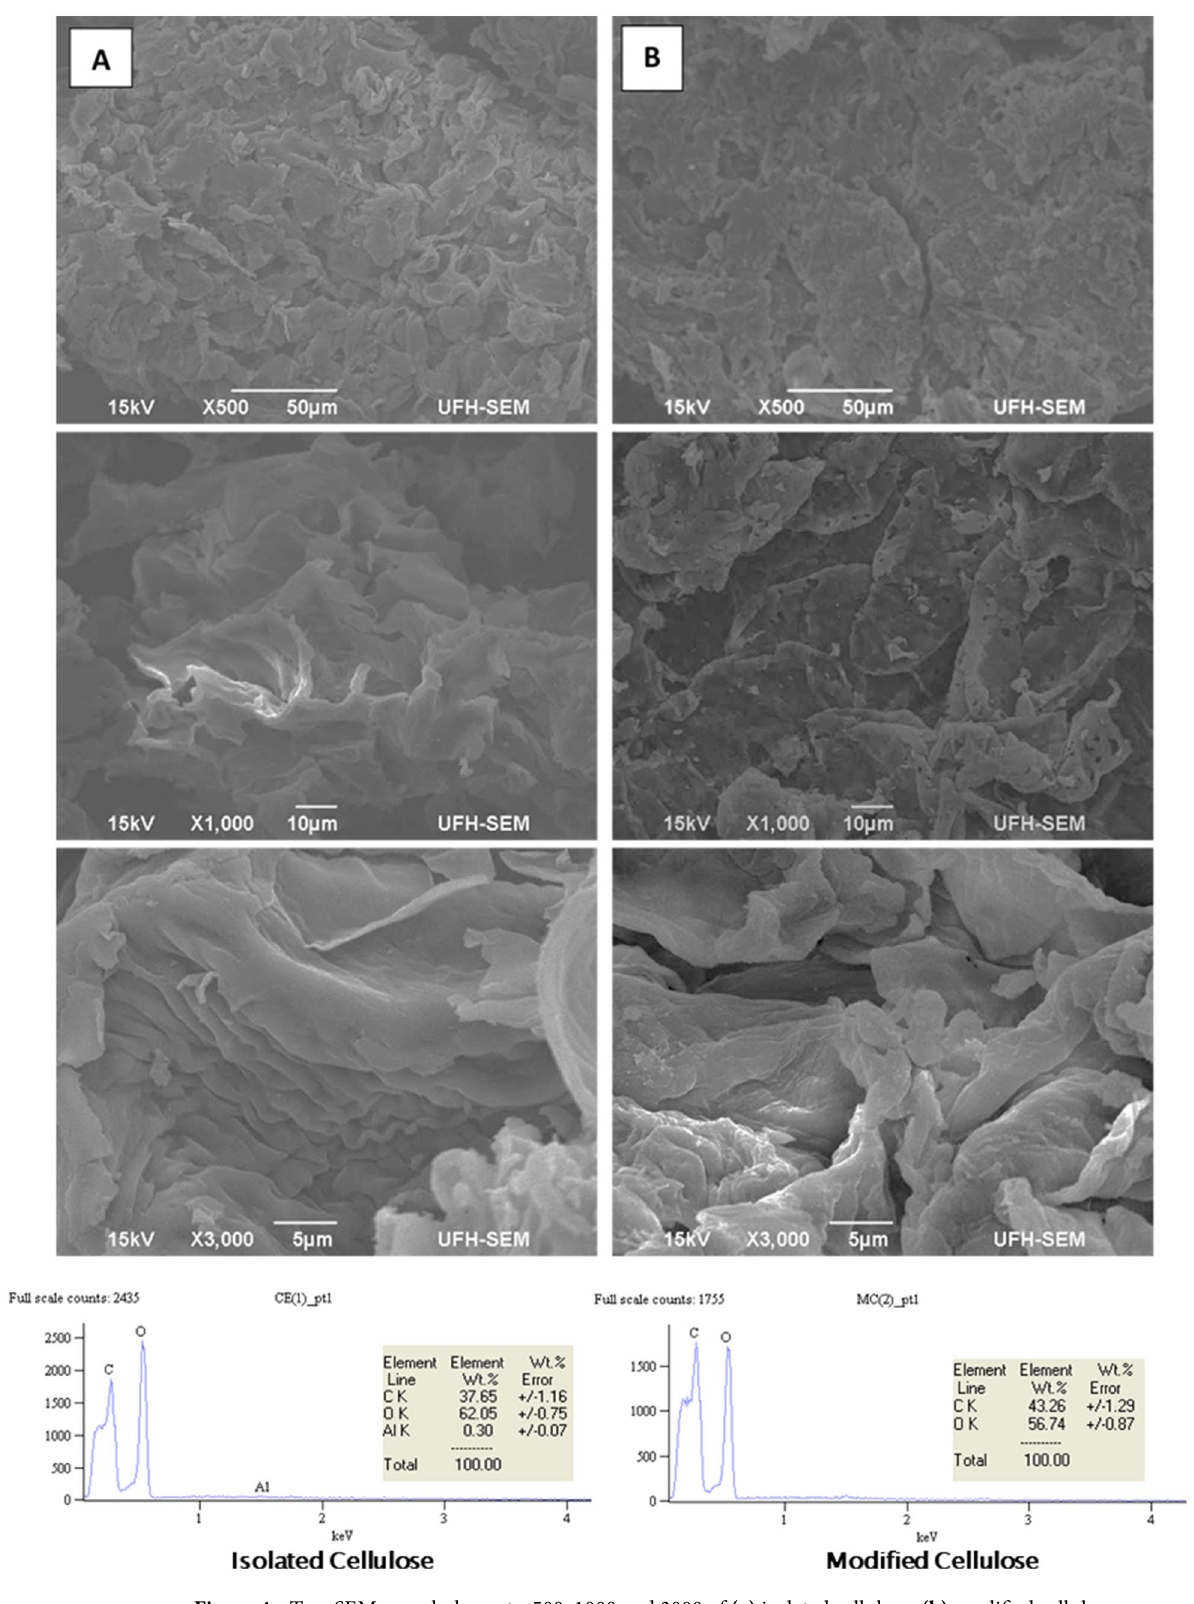
Figure 4. Top: SEM morphology at × 500, 1000 and 3000 of (a) isolated cellulose, (b) modified cellulose. Bottom: EDX spectra of isolated and modified